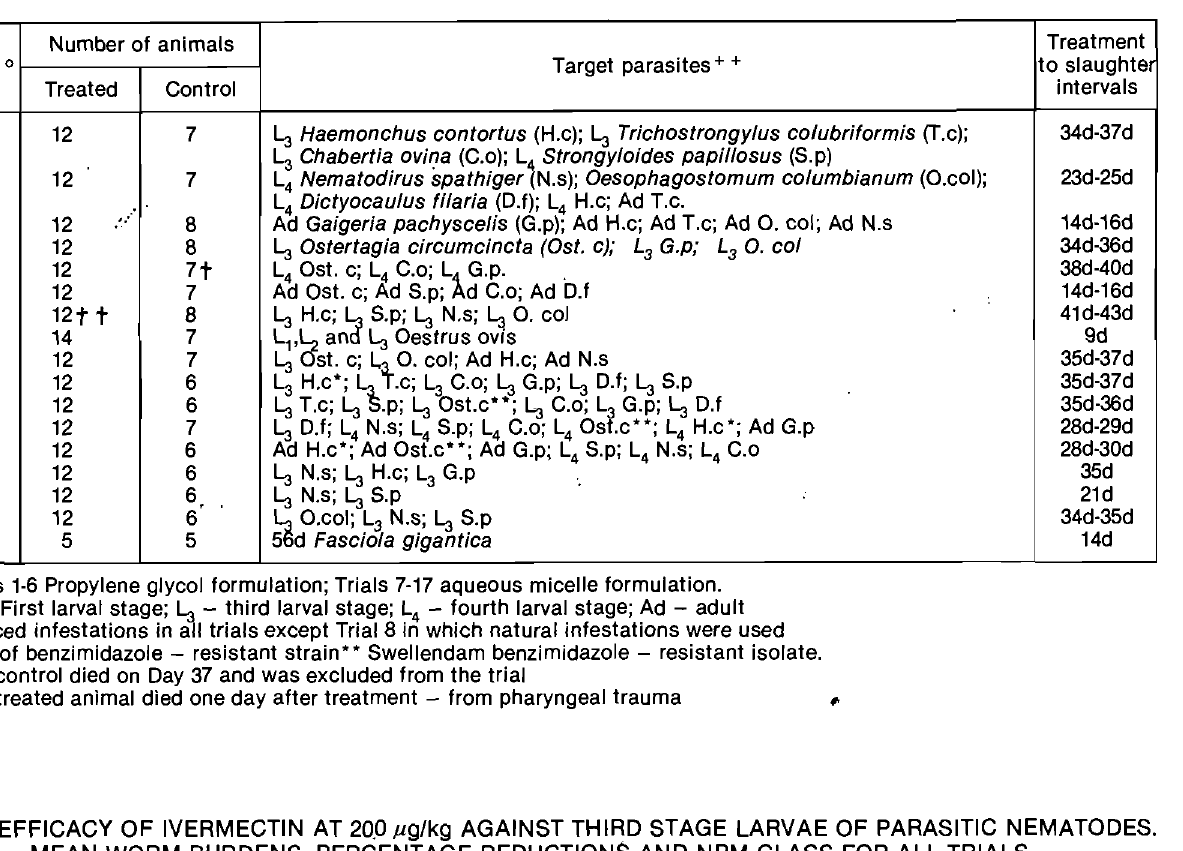
Table 2: EFFICACY OF IVERMECTIN AT 20,0 ,ug/kg AGAINST THIRD STAGE LARVAE OF PARASITIC NEMATODES. MEAN WORM BURDENS, PERCENTAGE REDUCTIONS AND NPM CLASS FOR ALL TRIALS Third larval No. of Mean worm burdens' Percentage